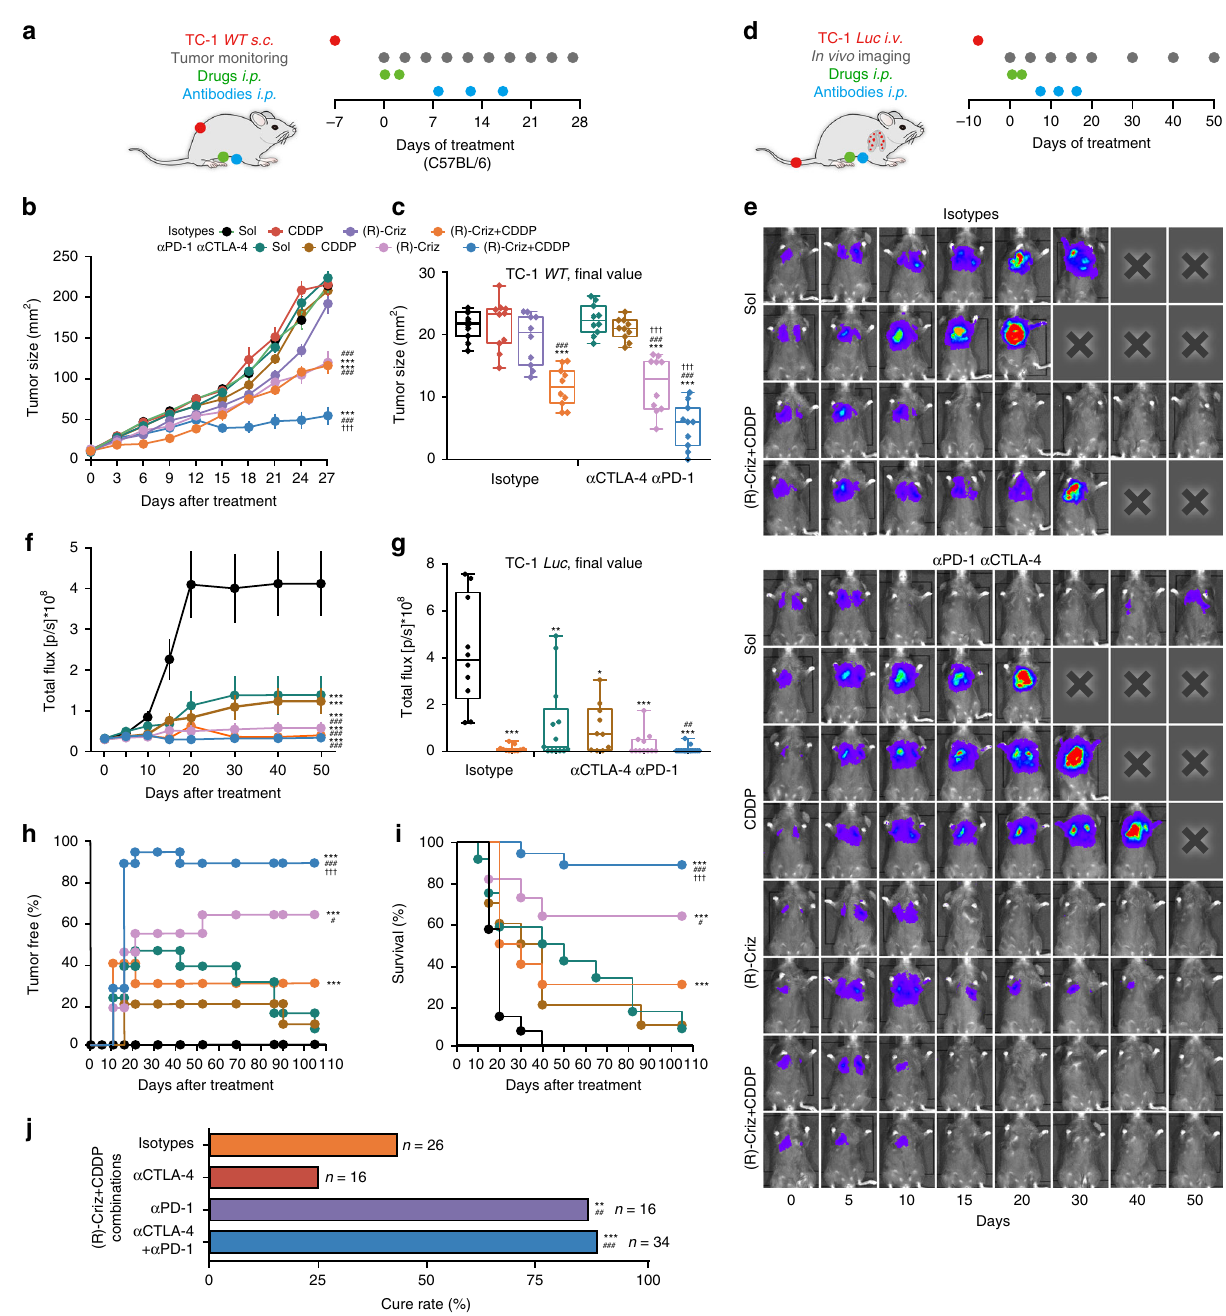
Fig. 7 Immunogenic chemotherapy of (R)-crizotinib sensitizes NSCLC tumors to checkpoint blockades. a – c Treatment of subcutaneous ( s.c .) TC1 tumors with injections of solvent control, CDDP alone or in combination with (R)-crizotinib. Isotype monocloncal antibodies (mAbs) or anti-PD-1 mAbs ( α pd-1) combined with anti-CTLA-4 mAbs ( α CTLA-4) were injected on day 8, 12, and 16 (schedule in a ). Tumor growth was monitored ( b , c ) and expressed as surface (mean ± s.e.m., b ) or size at endpoint (box plot, c ). d – j Treatment of orthotopic TC1 Luc tumors. Once the presence of lung cancer could be detected by bioluminescence (day 0), the animals were treated according to the scheme ( d ). Representative images of tumor development are shown in e ; average (mean ± s.e.m.) bioluminescence signals are reported in f ; fi nal values at endpoint are reported as box plot in g . The percentage of tumor free mice is reported in h ; overall survival is reported in i . Data in e – i include dual checkpoint blockade ( α CTLA-4/ α PD-1). The effects of dual as compared to single checkpoint blockade at day 70 are shown in j . Statistical signi fi cance was calculated by means of the ANOVA Type 2 (Wald test) ( b , f ), ANOVA test for multiple comparisons ( c , g ), Likelihood ratio test ( h , i ) or χ 2 test ( j ). * p < 0.05, ** p < 0.01, *** p < 0.001 as compared to control group with isotype; # p < 0.05, ## p < 0.01, ### p < 0.001 as compared to control group with the combination of α PD-1 and α CTLA-4; ††† p < 0.001 comparing isotype and α CTLA-4 and α PD-1 combination, n = minimum of 10 animals per